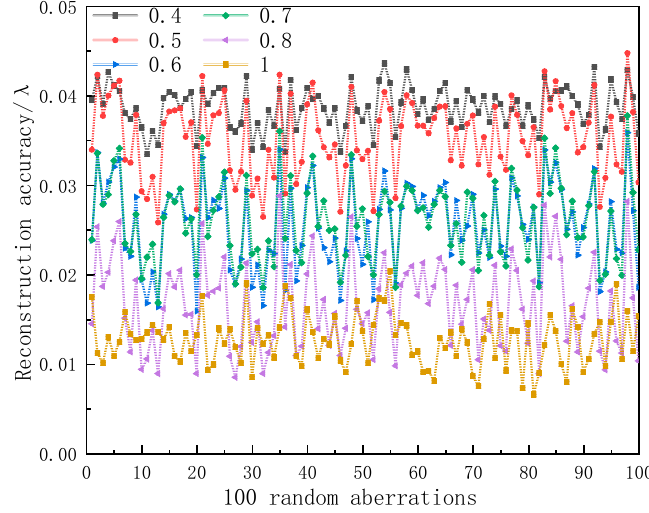
Figure 2. Wavefront reconstruction accuracy of 8 × 8 lens array with different duty cycles.